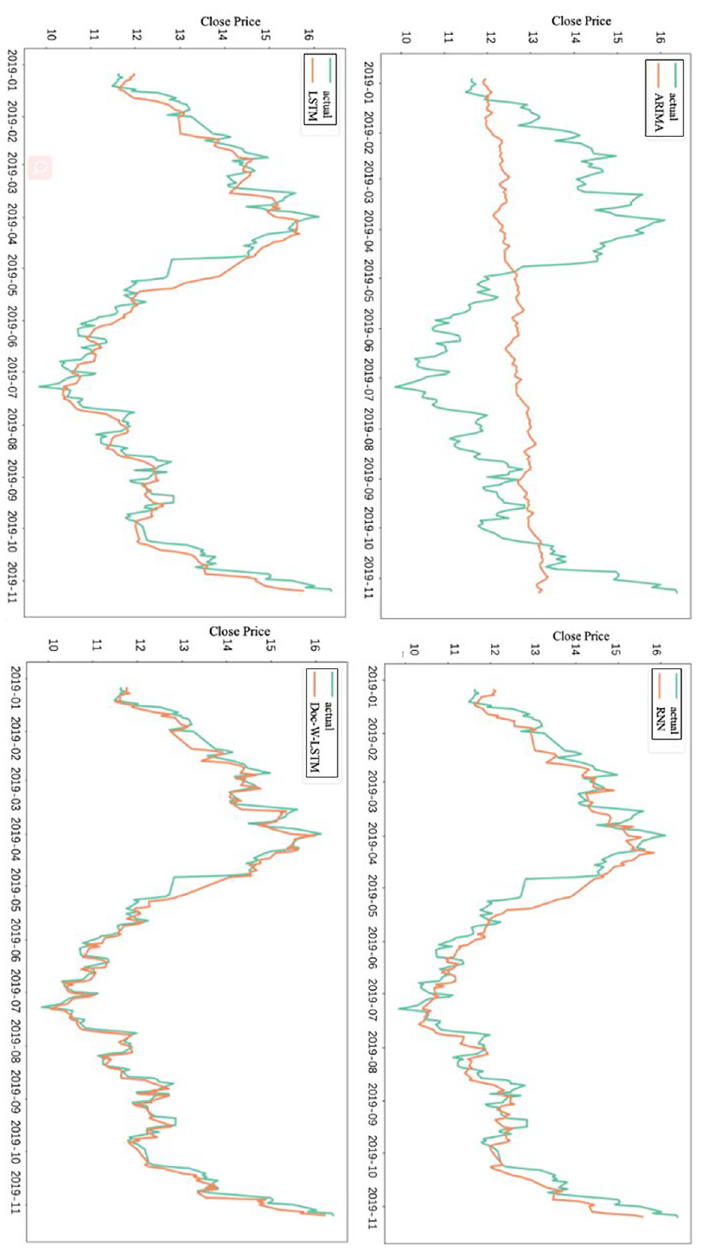
Figure 3. Fitting curve of different